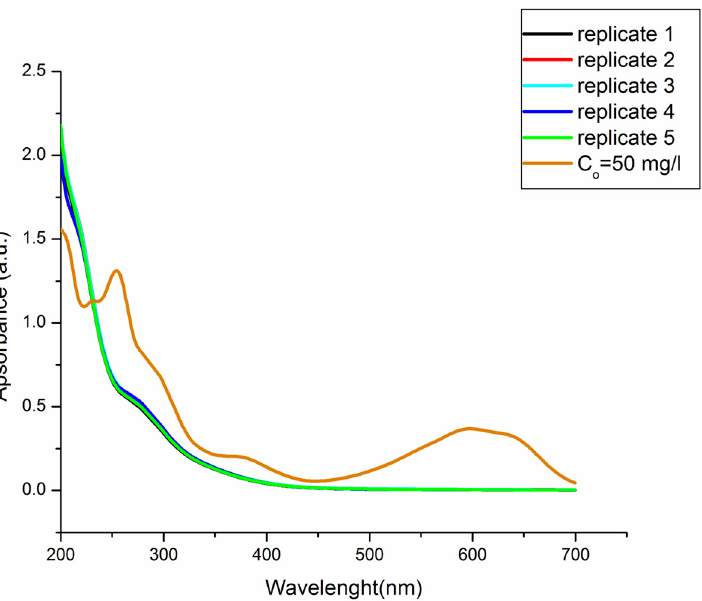
Figure 6. Spectra of the final effluent after decolorization under optimal conditions (performed in five replicates).